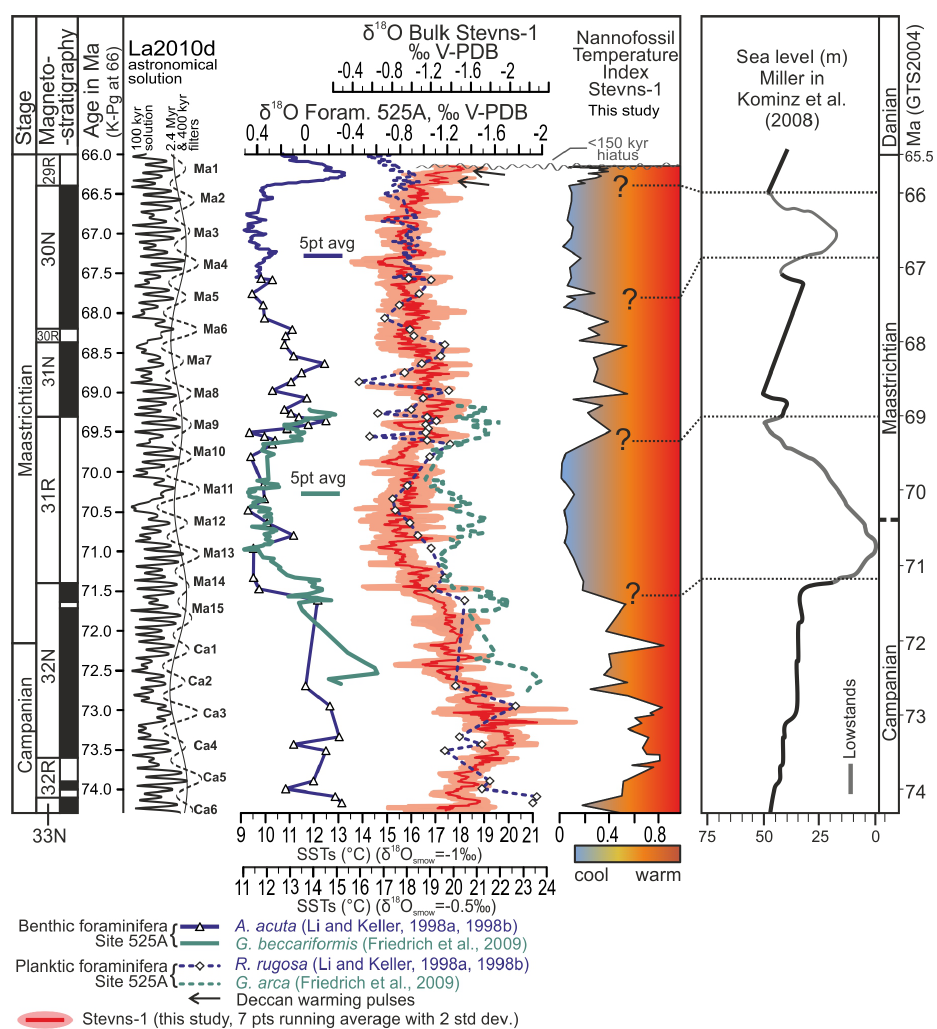
Figure 5. Stable oxygen isotope and calcareous nannofossil data of Stevns-1 compared to data on foraminifers of South Atlantic DSDP Site 525A. The age scale is based on the correlation of carbon isotope curves between Stevns-1, DSDP Site 525A and the astronomically calibrated ODP Site 762C. La2010d: astronomical solution from Laskar et al. (2011). Benthic and planktonic foraminiferal stable isotope data from Li and Keller (1998a, b) and Friedrich et al.